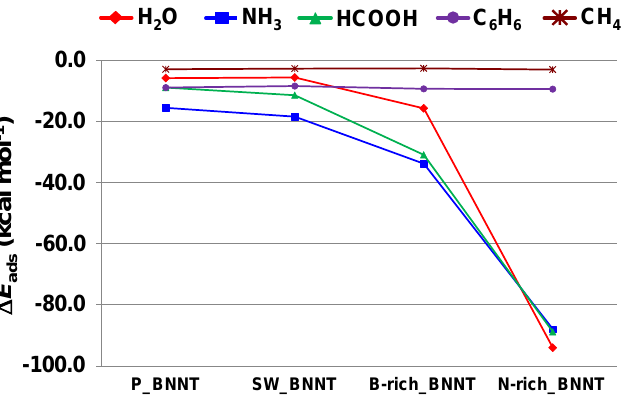
Figure 6. Variation of the adsorption energies ( ∆ E ads ) for the different probe molecules as a function of the BNNTs.